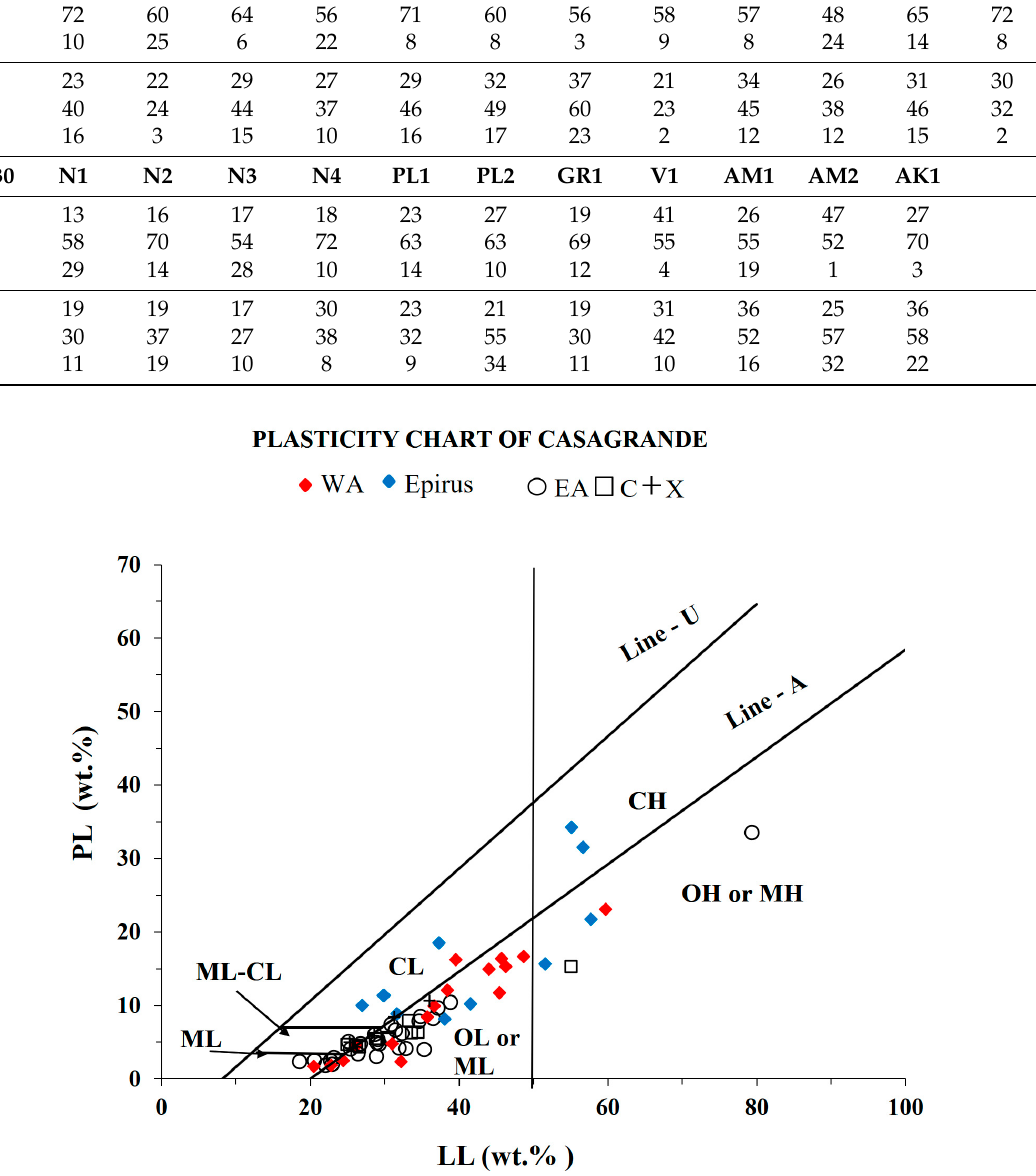
Figure 5. Plot on Casagrande’ s plasticity chart [34] of the studied clayey samples. Abbreviations: ML-CL = soils of clay and silt, ML = silt of low plasticity, OL or ML = organic silt or silt of low plasticity, OH or MH = organic silt or silt of high plasticity, CL = clay of low plasticity or lean clay, CH = clay of high plasticity or fat clay. The vertical line shows the liquid limit 50% that divides the chart into four main fields. The data for Eastern Achaean, Corinthia, and Xyloakastro are given elsewhere [12]. Table 3. The Atterberg limit values (in wt.%) for the samples considered in the present study. Ab- breviations: LL = liquid limit; PL = plastic limit; Ip = plasticity index and the proportions of the main granulometric fractions of the studied clay-rich raw material in wt.%.